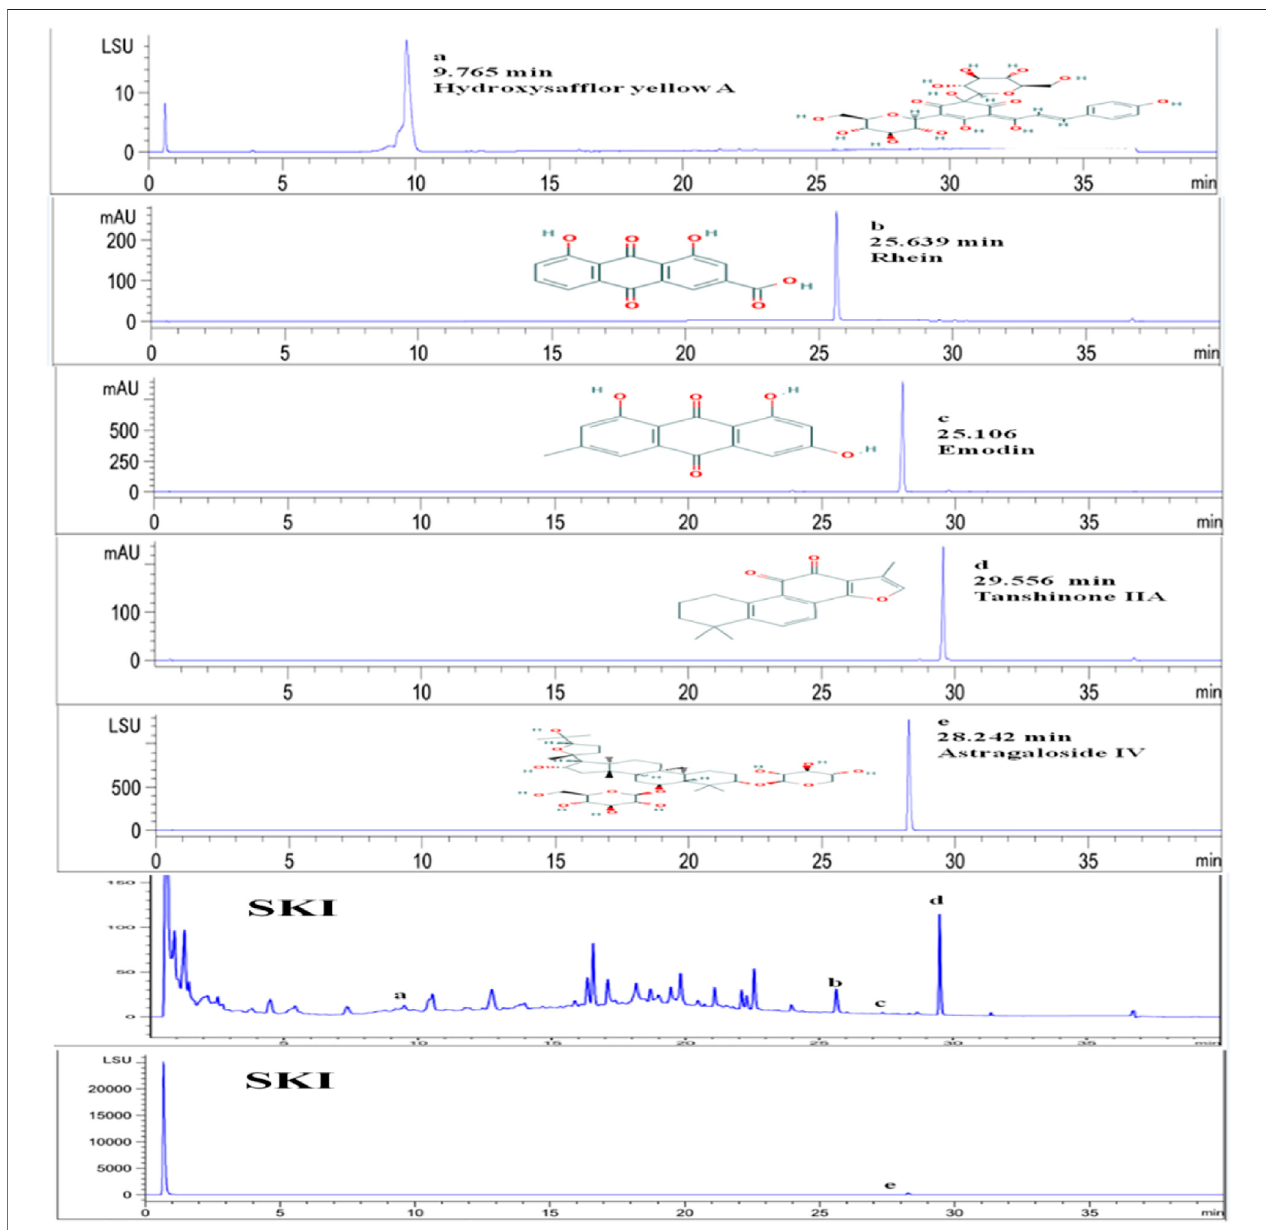
FIGURE 1 | Qualitative analysis of fi ve main effective components of Shenkang injection.